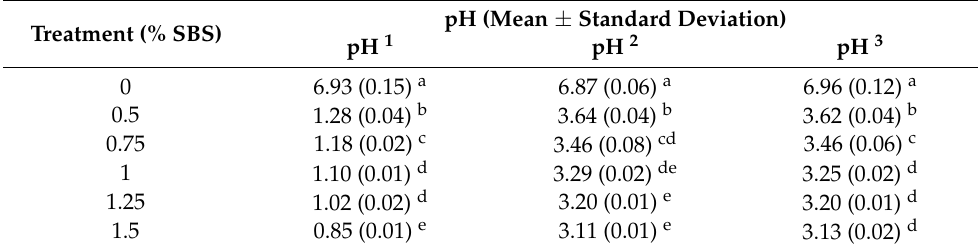
Table 1. Mean (sd) pH values taken during the tempering experiments.